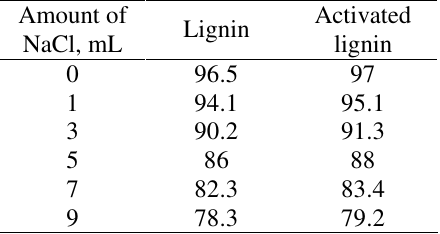
Table 6. Effect of NaCl on Ni (II)